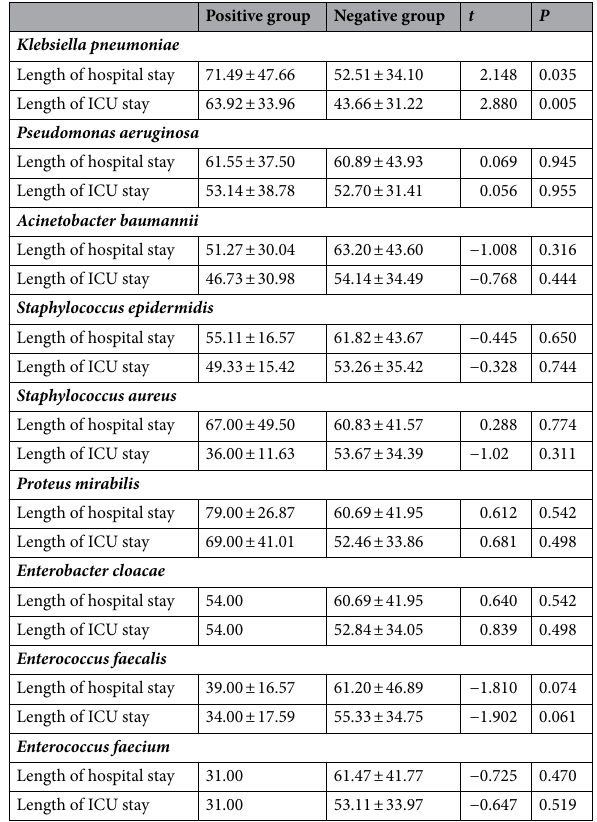
Table 4. The effect of different bacteria in blood culture on the length of hospital and ICU stays of burn patients.